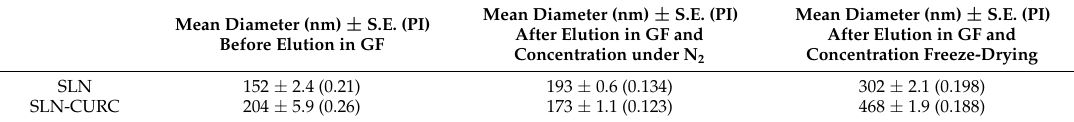
Table 6. Mean diameter ± standard error (PI) of empty nanoparticles suspensions in Pluronic ® F68 with sodium taurocholate (Na TC) as bile salt (SLN) and SLNs loaded with 9 mg CURC (SLN-CURC), before and after elution in GF and concentration with two different methods: concentration under N 2 or